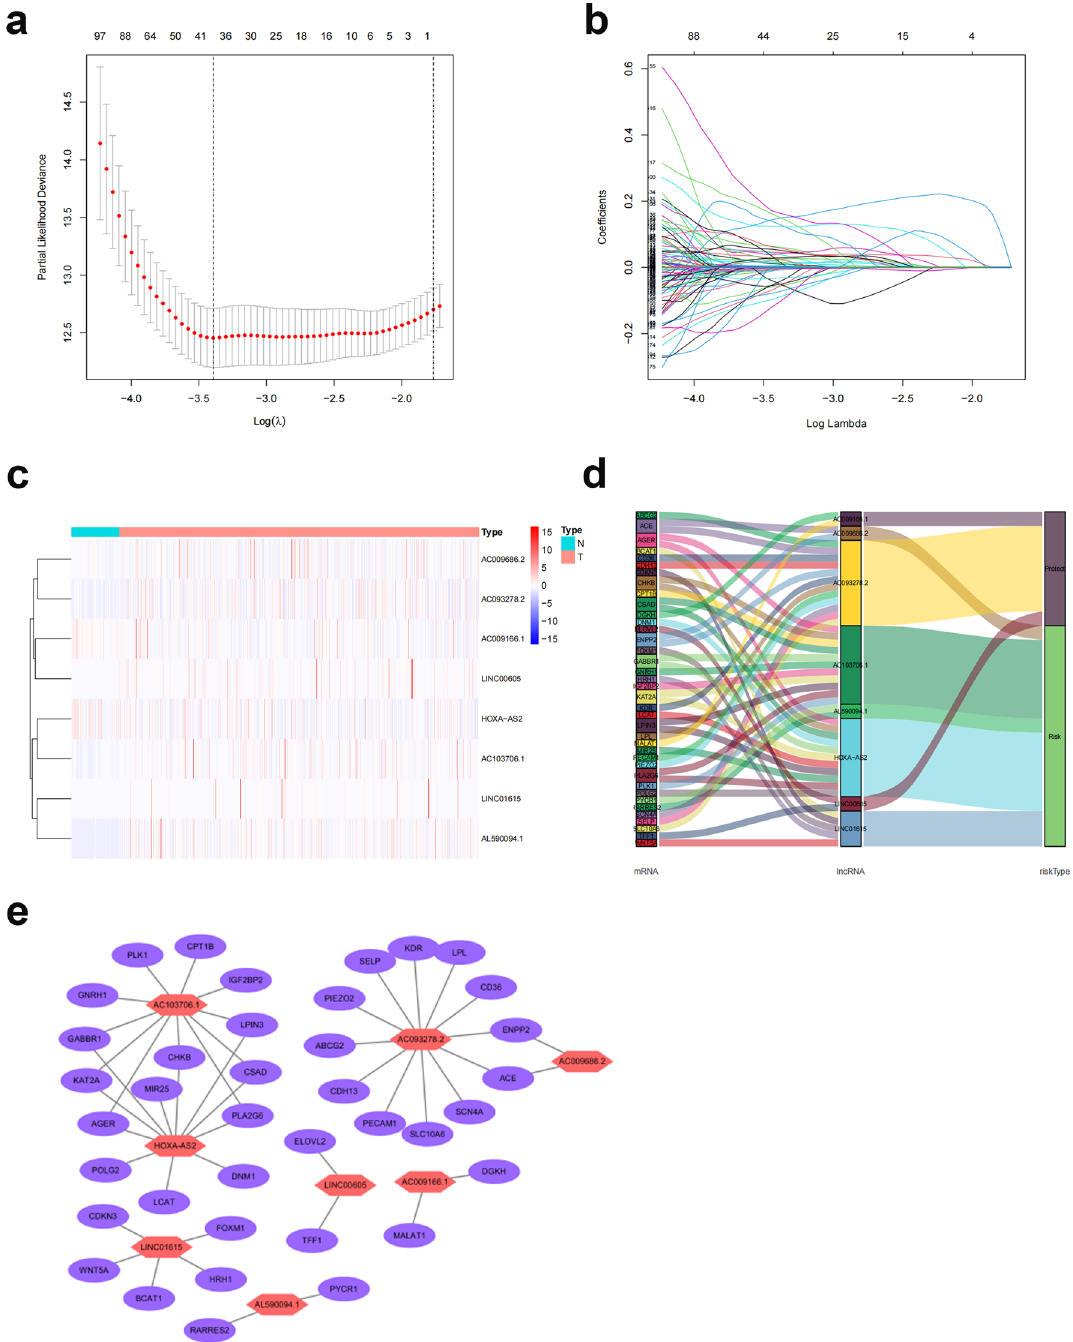
Figure 4. Analysis of the expected signal, including screening, expression levels, and lncRNA ‒ mRNA networks for the eight lncRNAs related to FAM. ( a ) Tenfold cross-validation error rate plot. ( b ) LASSO coefficient profiles of FAM-associated lncRNAs. ( c ) Heatmap (red represents high expression, whereas blue represents low expression) of the eight FAM-associated lncRNAs between the normal (brilliant blue) and the tumor tissues (red) (R software (version 4.2.1, URL: http:// www.r- proje ct. org)). ( d ) Prognostic FAM-associated lncRNA coexpression network. ( e ) A Sankey diagram of lncRNAs linked with prognostic FAM. Long non-coding RNAs, lncRNAs; renal clear cell carcinoma,